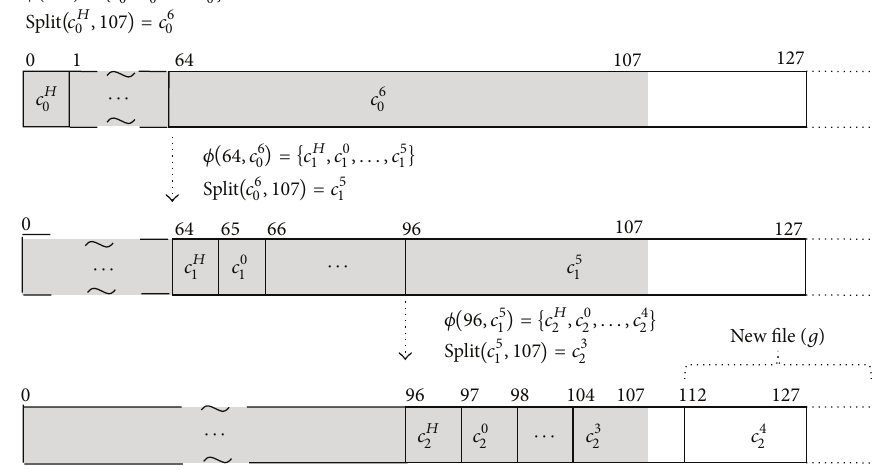
Figure 2: An example of chunk